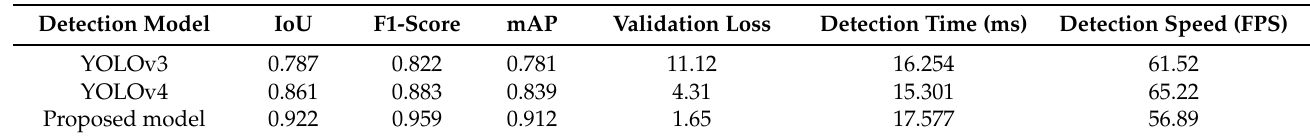
Table 4. Comparison of IoU, F1 Score, final loss, detection speed, and average detection time between YOLOv3, YOLOv4, and the proposed model. Detection Model